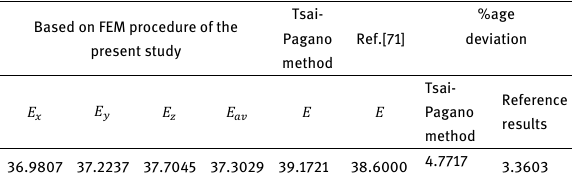
Table 2: Comparison of elastic modulus (in GPa) of Mg-ESF nanocomposite.